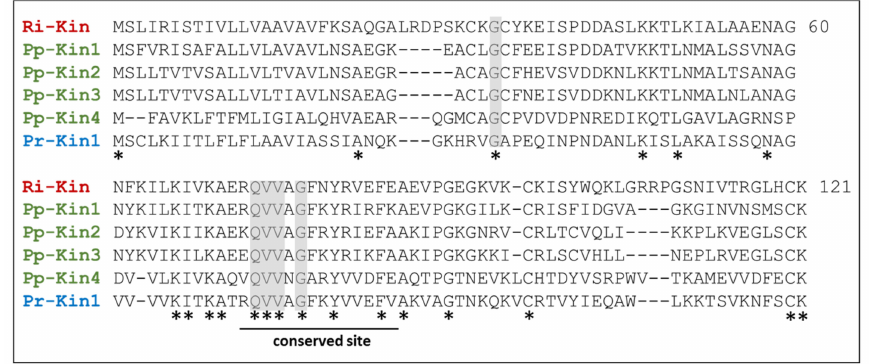
Figure 10. Sequence alignment of assassin bug kininogens. Kininogen sequences from R. iracundus , P. plagipennis, and P. rhadamanthus were aligned together. The conserved proteinase inhibitor cystatin site (Arg 72–Glu 85, Interproscan, IPR018073) is indicated with a line. Putative protease inhibition sites are highlighted in gray. Conserved amino acids are shown with asterisks